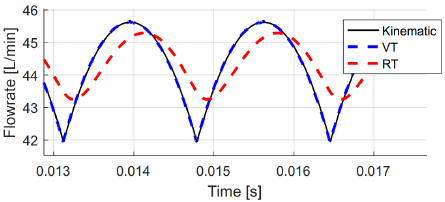
Figure 1. Flow pulsation. Data from the book [2].